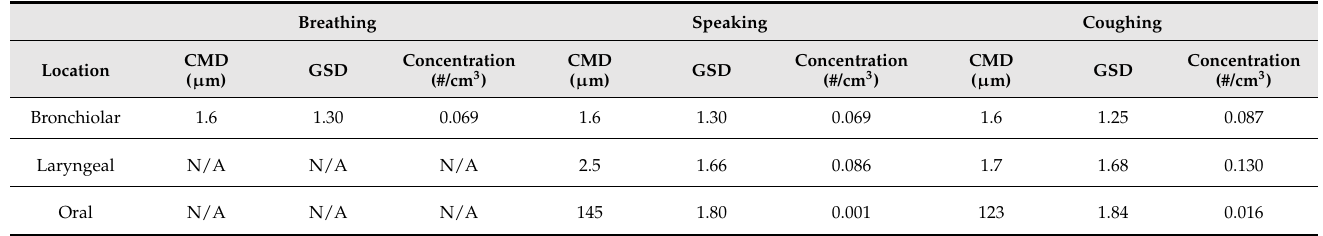
Table A2. Size distribution of particles emitted via breathing, speaking, and